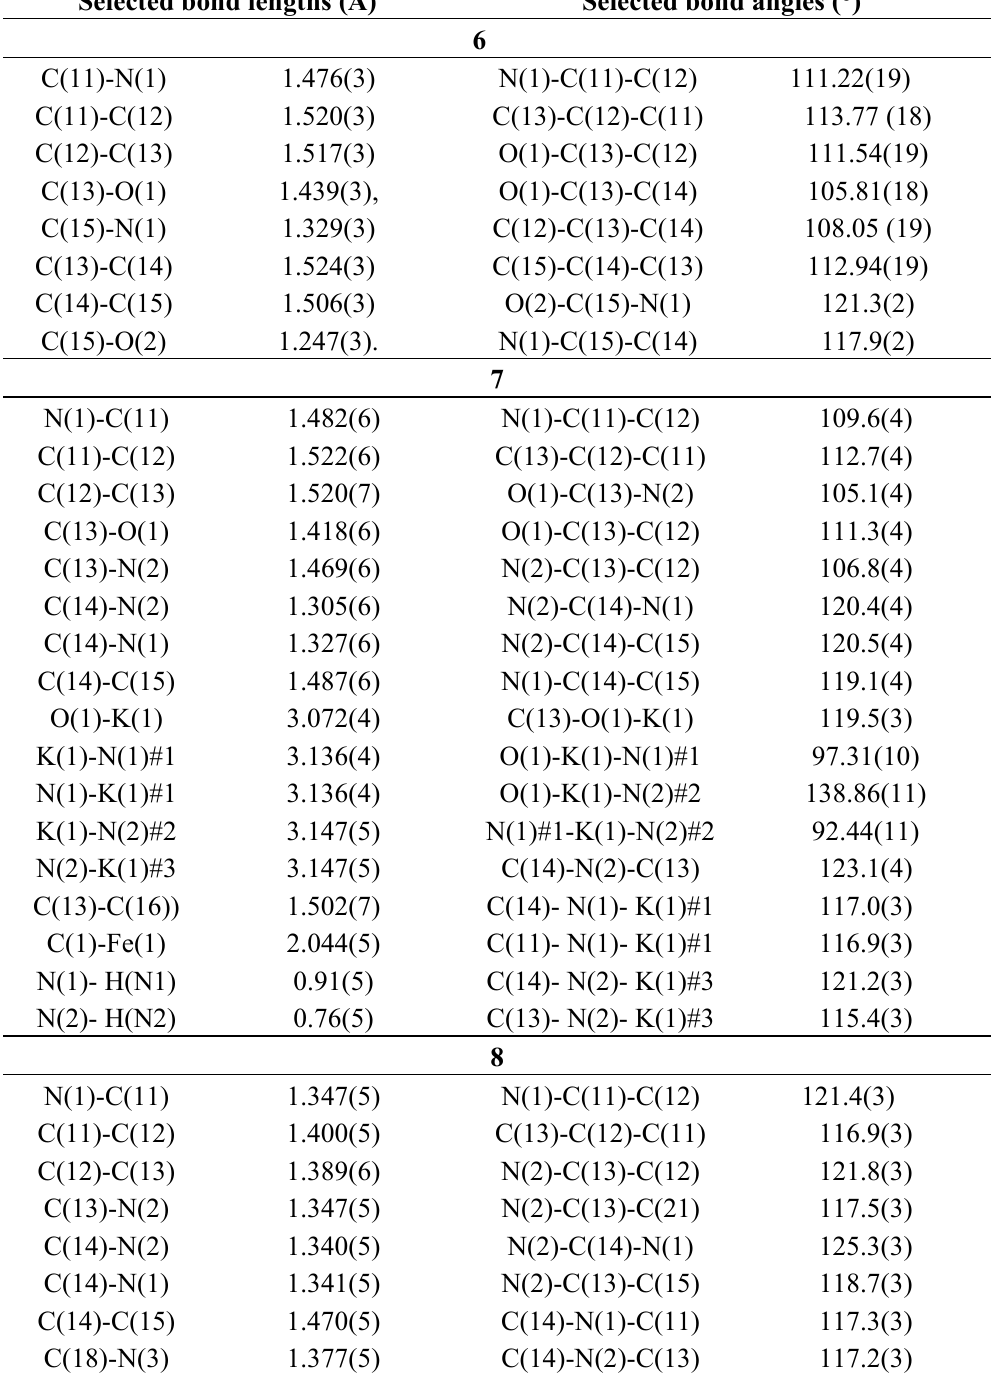
Table 1. Selected bond lengths and bond angles for compounds 6 , 7 and 8